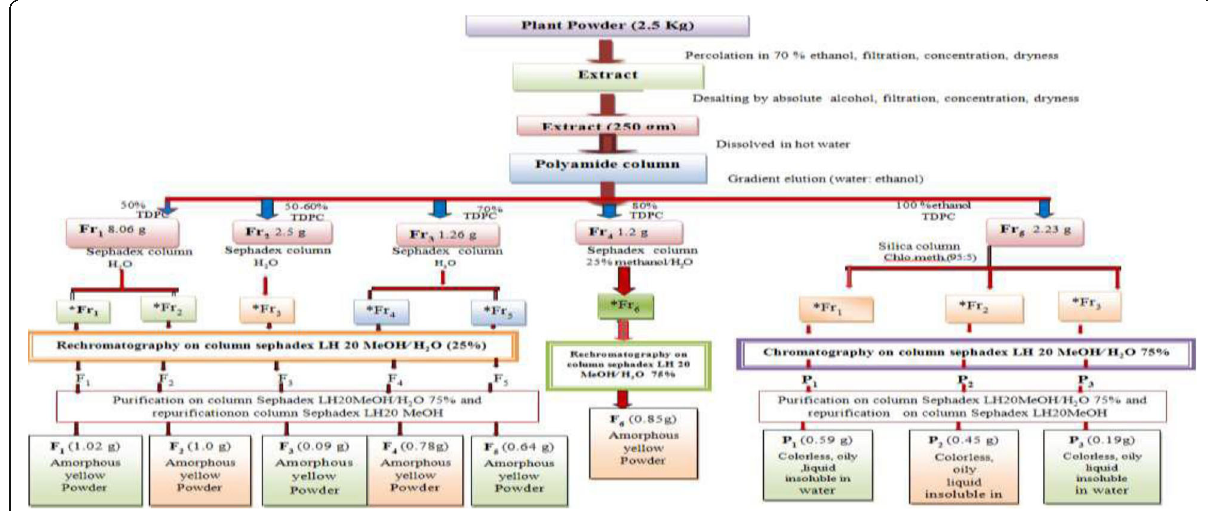
Fig. 1 Scheme of Separation of flavonoids and phenolics from the whole plant of P. angustifolia